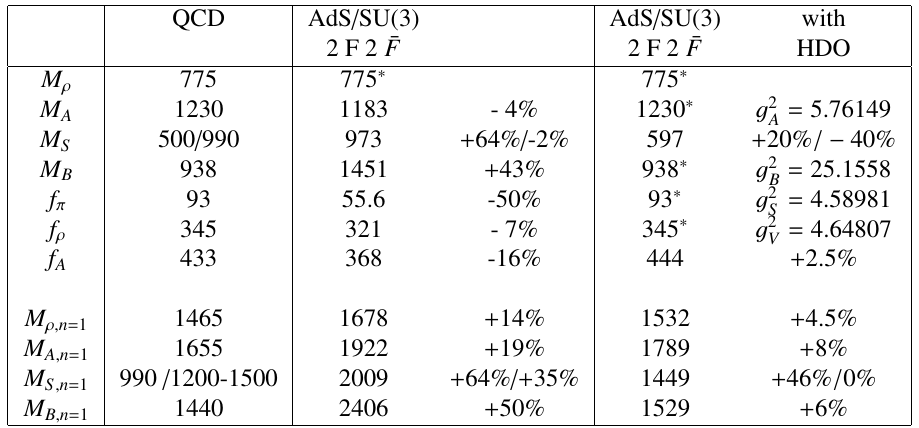
Table 1. The predictions for masses and decay constants (in MeV) for N f = 2 SU(3) gauge theory. The columns show the QCD value, the holographic prediction for the theory with massless quarks and the perfected holographic QCD theory with HDOs. The ⇢ -meson mass has been used to set the scale and other quantities that are used to fix the HDO couplings are indicated by the